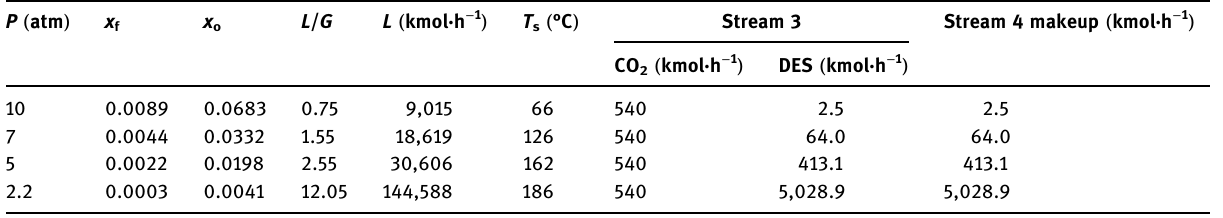
Table 2: The performance of CO 2 capture process at selected absorber pressure values with 90% recovery P ( atm